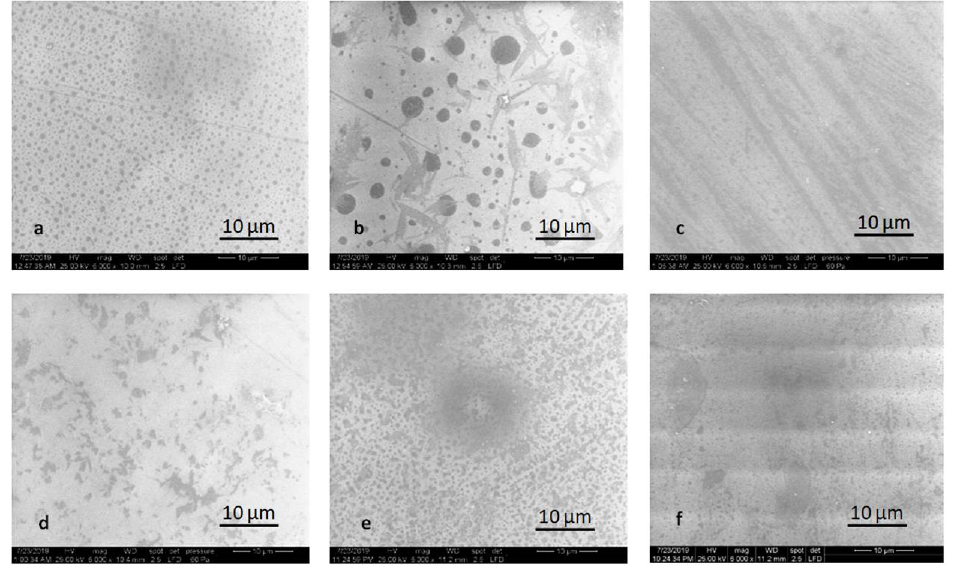
Figure 6. SEM images of the glazed samples: ( a ) LDS-P-G-HT, ( b ) LDS-P-G-MT, ( c ) LDS-M-G-MT, ( d ) ZLS-P-G-HT, ( e ) ZLS-P-G-MT, and ( f ) ZLS-M-G-MT.